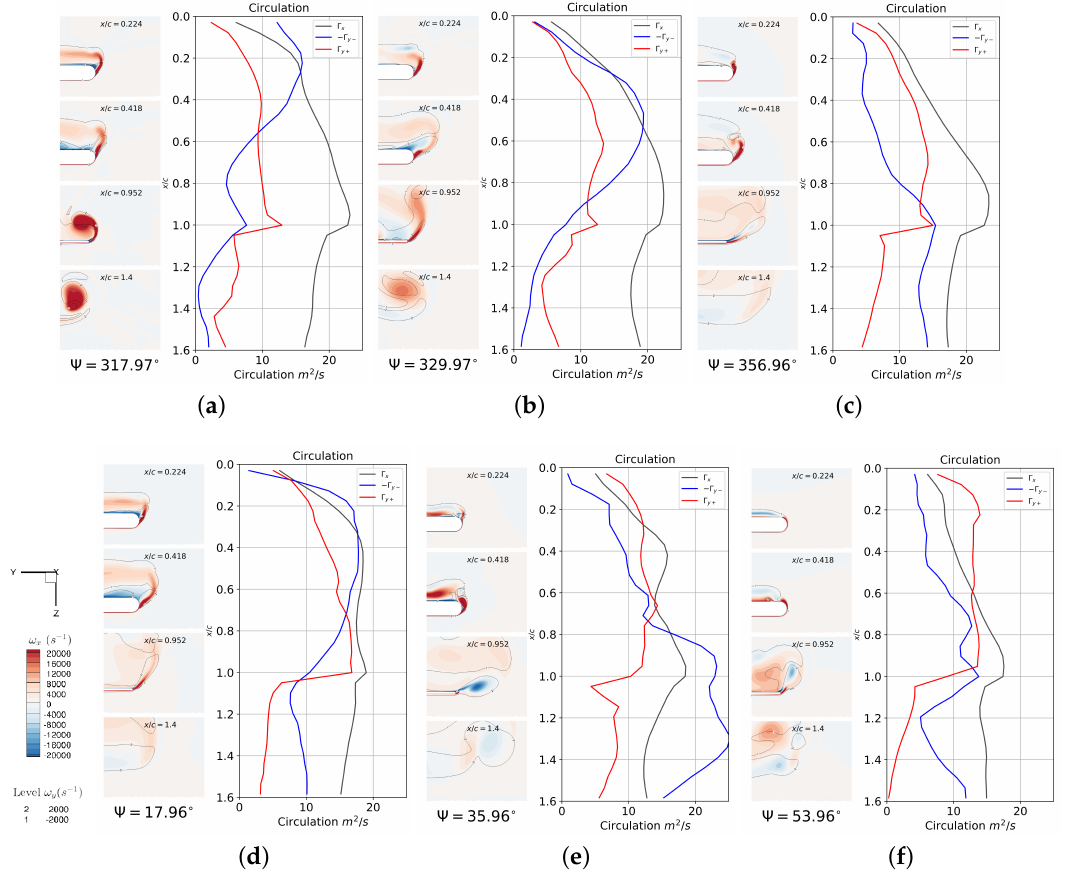
Figure 10. Snapshots of the flood contour of vorticity field ω x and the contour of ω y in blade tip area (0.94 < r / R < 1.125) at different chord-wise sections; The circulation Γ i ± = positions: Ψ = ( a ) 318 ◦ ; ( b ) 330 ◦ ; ( c ) 357 ◦ ; ( d ) 18 ◦ ; ( e ) 36 ◦ ; ( f ) 54 ◦